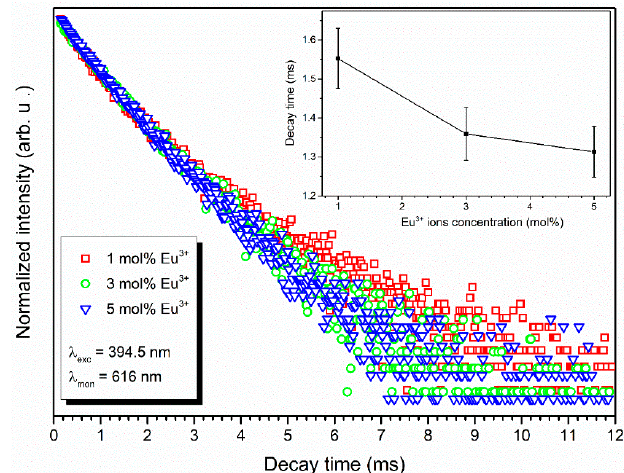
Figure 8. Emission kinetics of the Eu 3 + :Ca 10 (PO 4 ) 6 (OH) 2 nanoparticles embedded into poly(L-lactide) composites obtained by using the extrusion method. as a function of the concentration of optically active ions. Insert: The decay time as a function of Eu 3+ ions concentration.